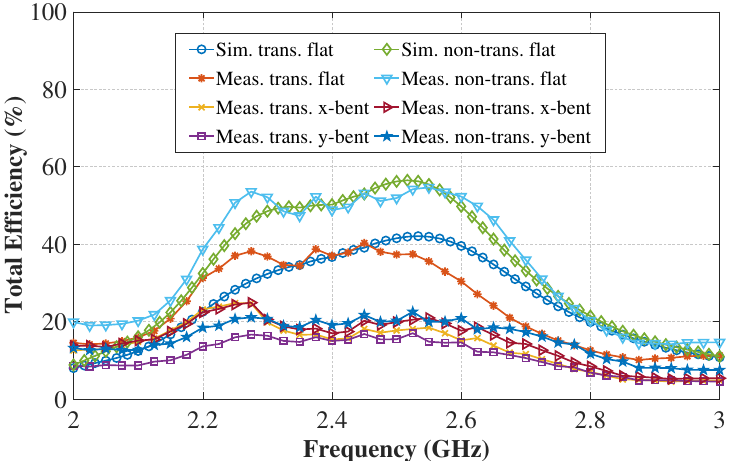
Figure 25. Simulated and measured total efficiency vs. frequency of the transparent and non- transparent